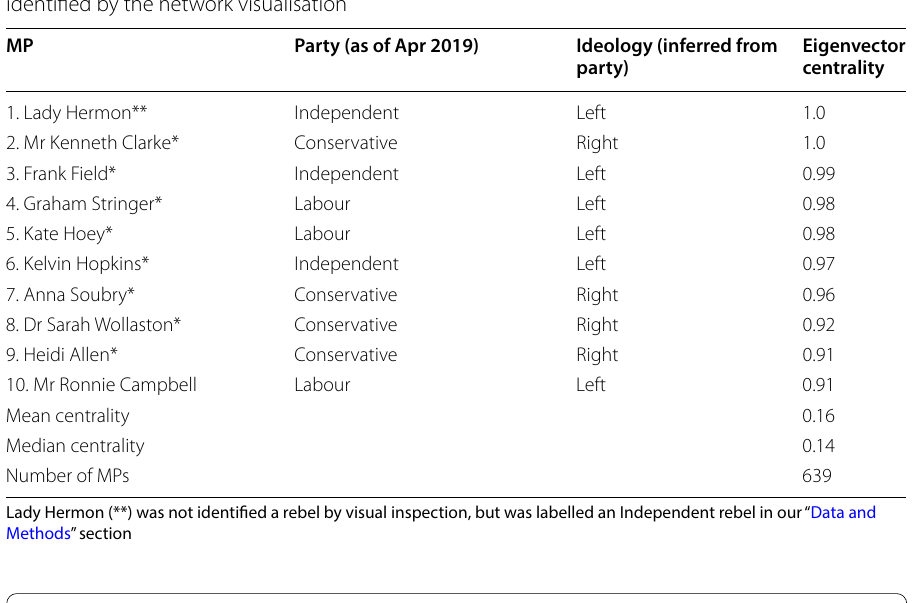
Table 2 Top 10 rebels based on eigenvector centrality. Asterisks (*) indicate that the MP was also identified by the network visualisation MP Party (as of Apr 2019) Ideology (inferred from